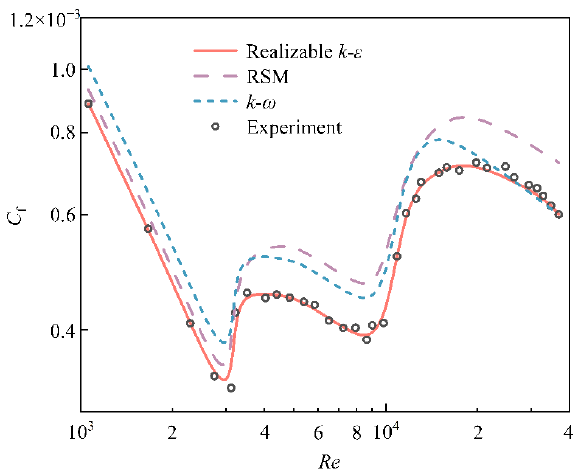
Figure 4. Comparison of numerical results for three turbulence models and Nakabayashi’s experi- mental